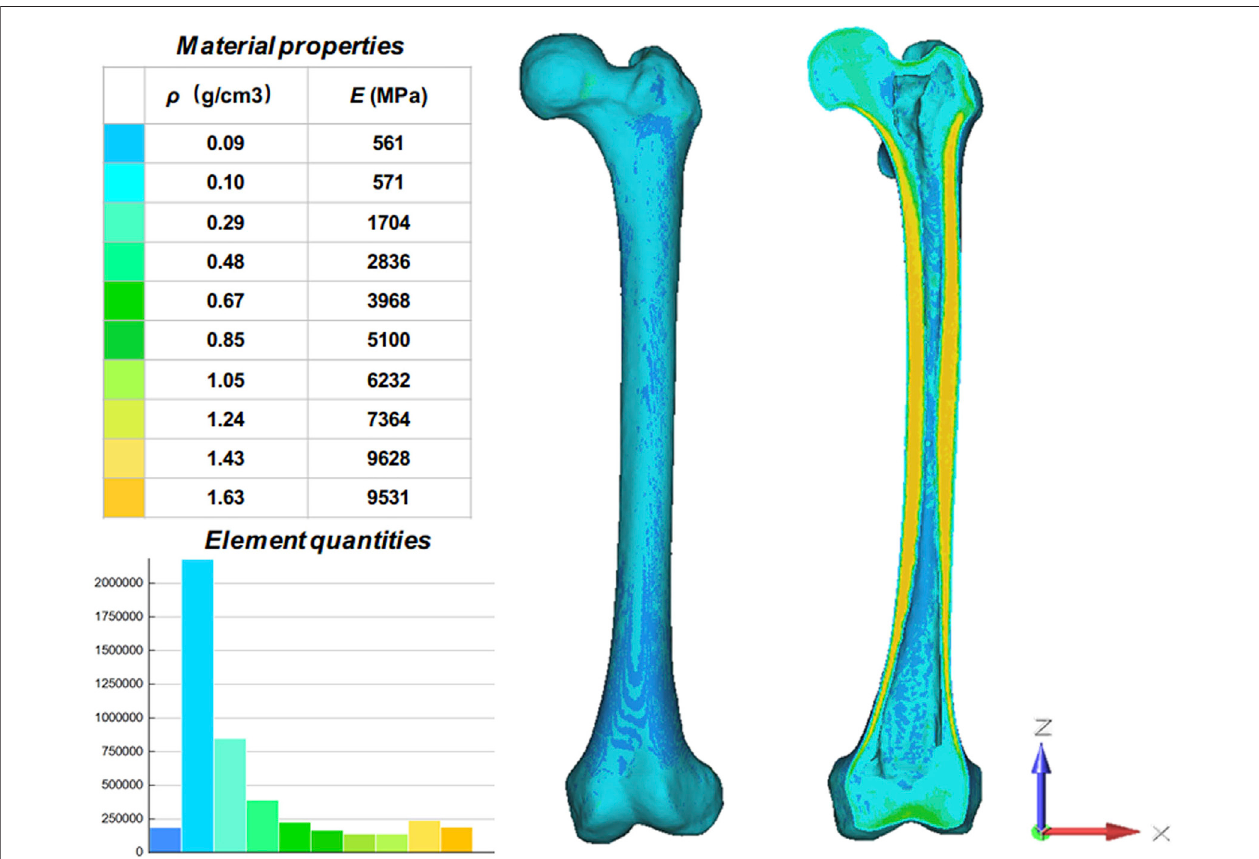
FIGURE1| Materialpropertiesoftheinhomogeneousfemur.Thefemurwasdividedintotenmaterialpropertieswithtendifferentcolors. ρ :Bonedensity;E:Elastic modulus.